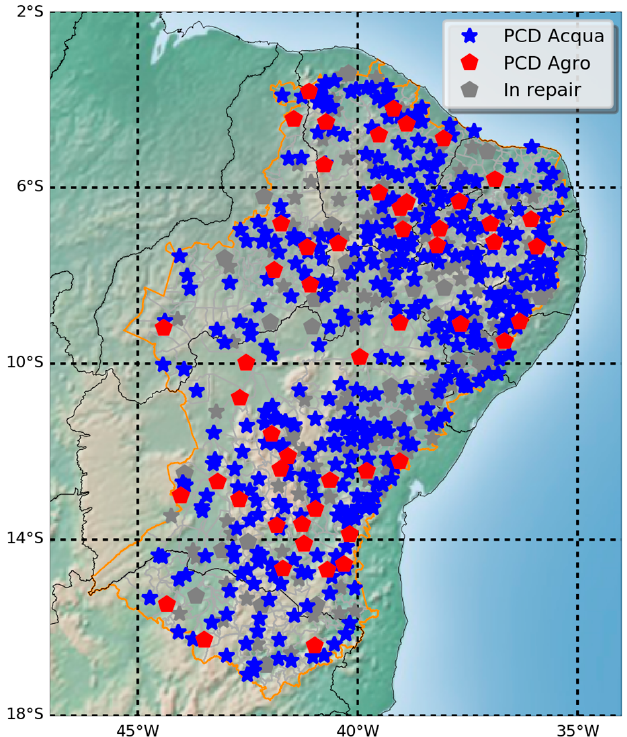
Figure 1. Data collection platforms over the Brazilian semiarid region as of 31 March 2016. Gray symbols (stars and pentagons) denote offline stations at the time.